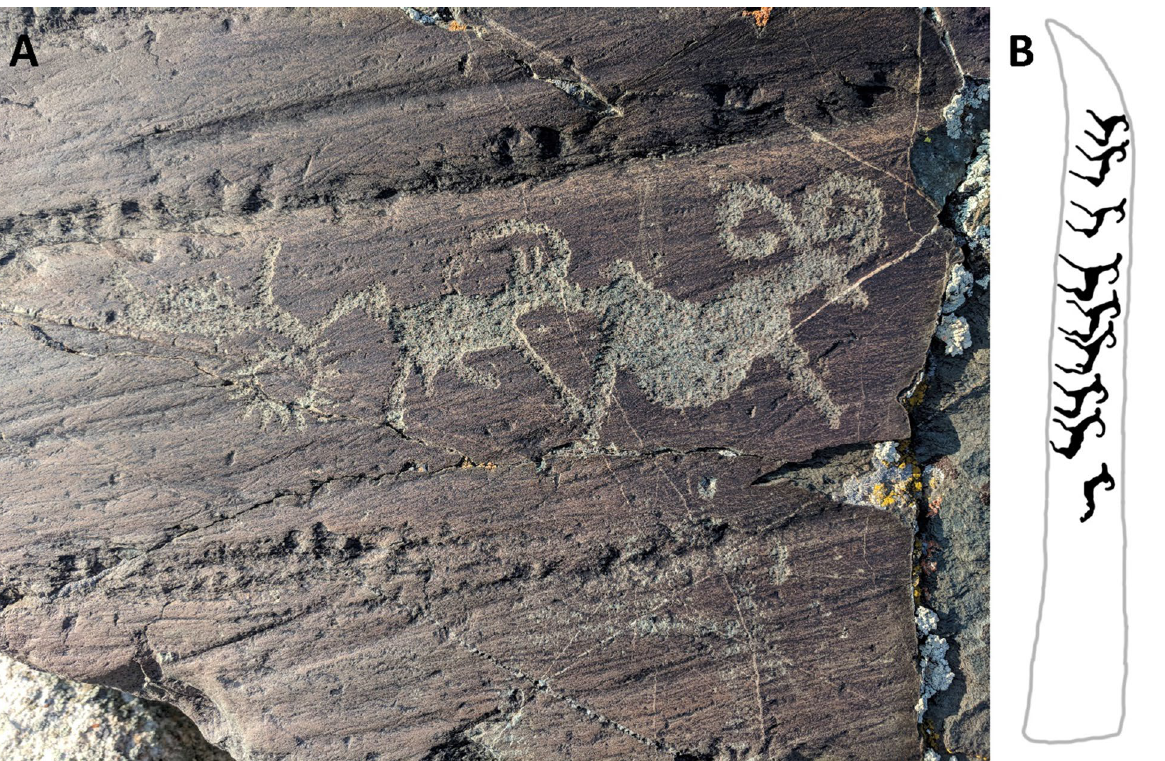
Figure 6. ( A , left) A petroglyph panel at Khultsuut depicts argali sheep and ibex. ( B , right): a side panel of what may be a herd of argali sheep adorns the side of deer stone from Arkhangai Province, Bayan-Tsagaan Gol (modified from Volkov 54 ). Image: William